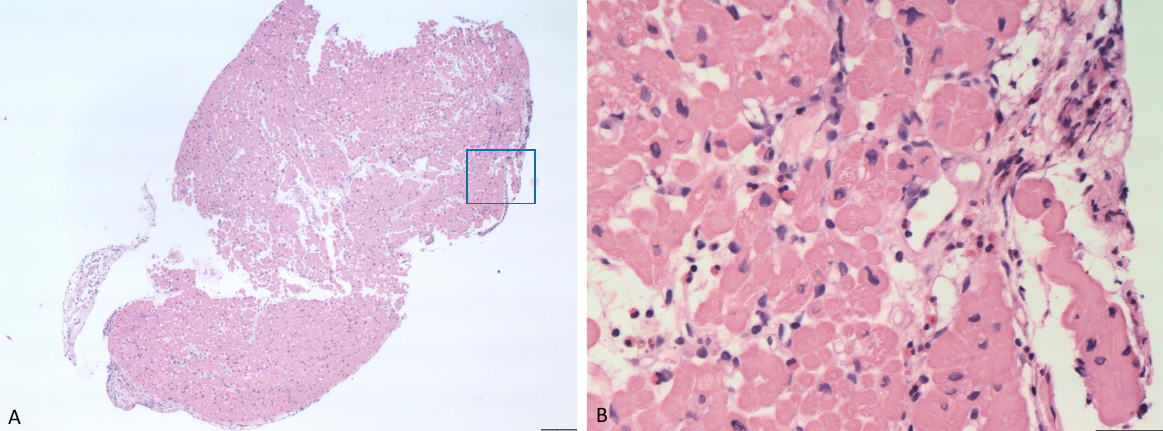
Figure 4. ( A ) Endomyocardial biopsy specimen, showing at higher magnification ( B ) an interstitial inflammatory infiltrate with eosinophils (Haematoxylin and eosin, scale bars 200 micron ( A ) and 50 micron ( B ).